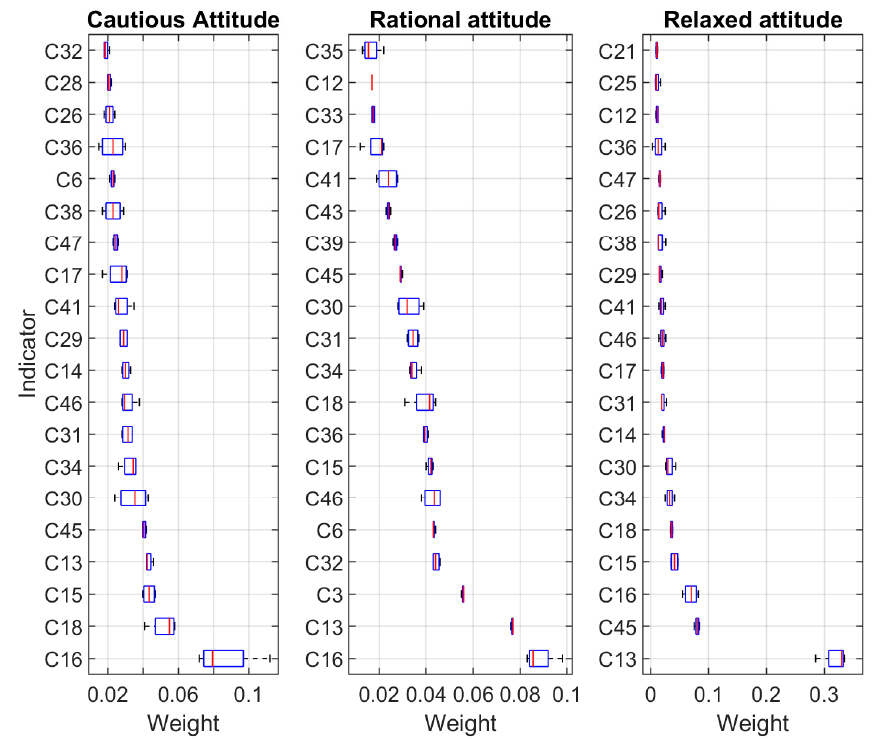
Figure 1. Comprehensive weights for cautious, rational, and relaxed attitude (only the 20 largest weights are shown for each group).